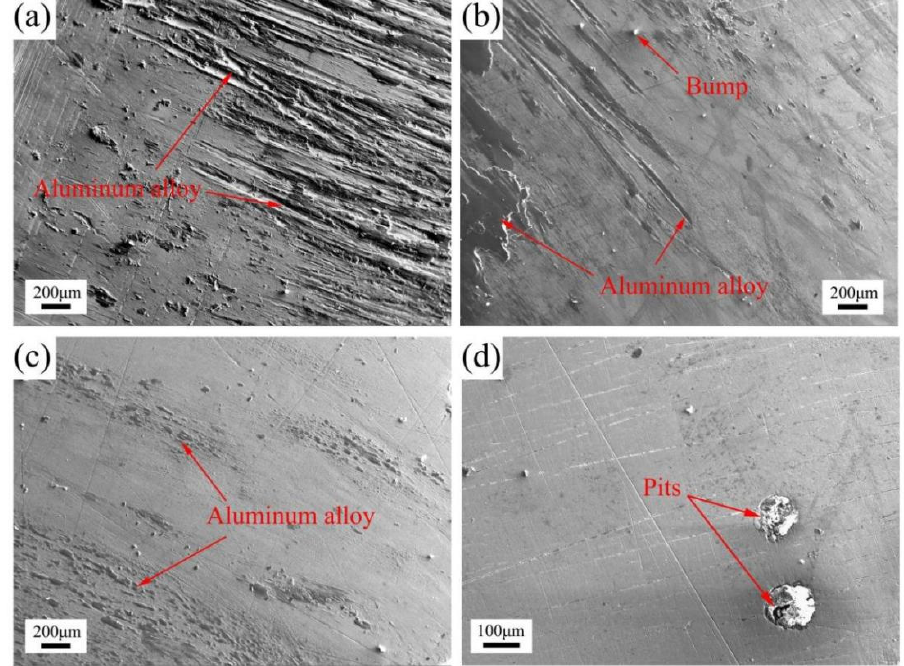
Figure 13. SEM micrographs of the worn surface of pin: ( a ) TN5; ( b ) TN10; ( c ) TN15; ( d ) the etch pits filled with aluminum alloy on TN10.